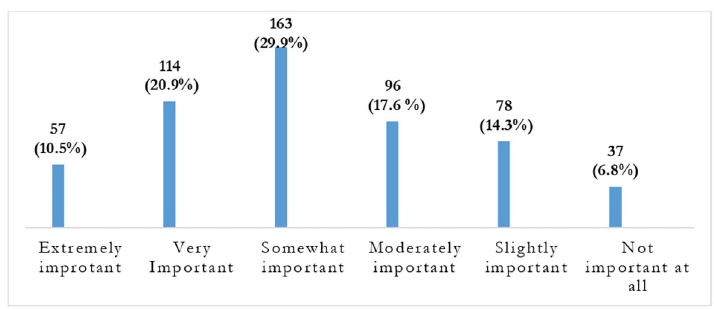
Figure 3. Response of students regarding importance of recorded video